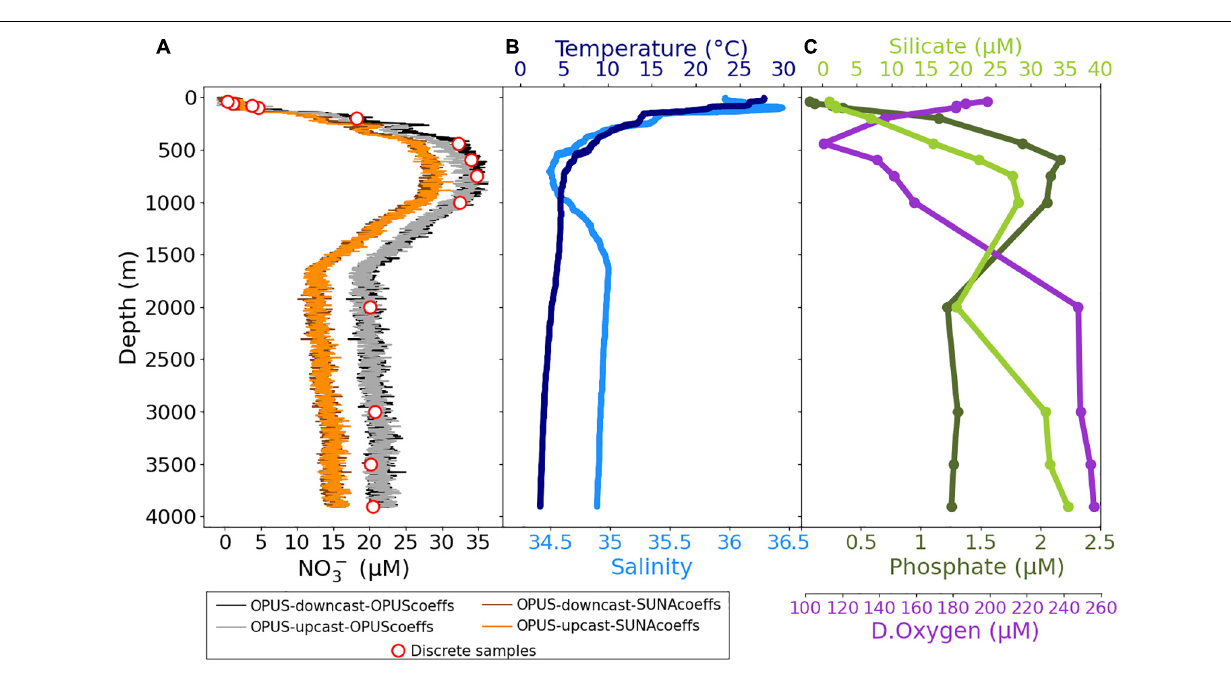
FIGURE 14 | Vertical profiles of (A) NO 3 − concentrations ( µ M), (B) in situ temperature ( ◦ C), and salinity, (C) silicate ( µ M), phosphate ( µ M), and dissolved oxygen ( µ M) for cruise M158 cast CTD71 (00 ◦ 00.00 (cid:48) S, 30 ◦ 00.00 (cid:48) W). Black lines show NO 3 − values of the post-processed OPUS data obtained during the downcast, gray lines show NO 3 − values of the upcast profile, and red circles are for the discrete water samples analyzed in the laboratory by the wet chemistry–based method. Brown and orange lines are for the NO 3 − values of the post-processed OPUS data with the SUNA coefficients (Johnson et al.,